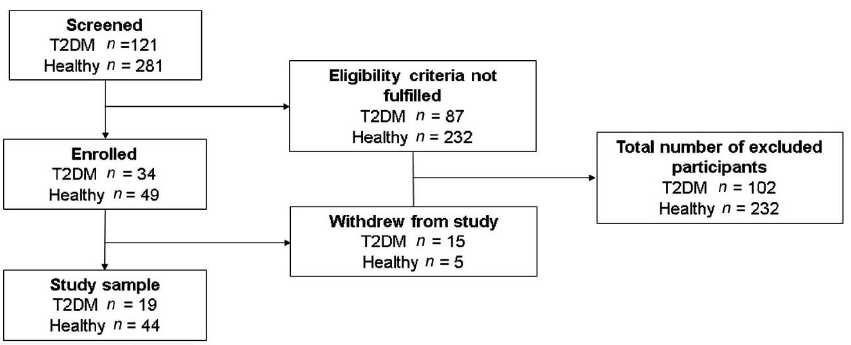
Figure 1. Diagram of enrollment including healthy controls and participants with type 2 diabetes (T2DM).